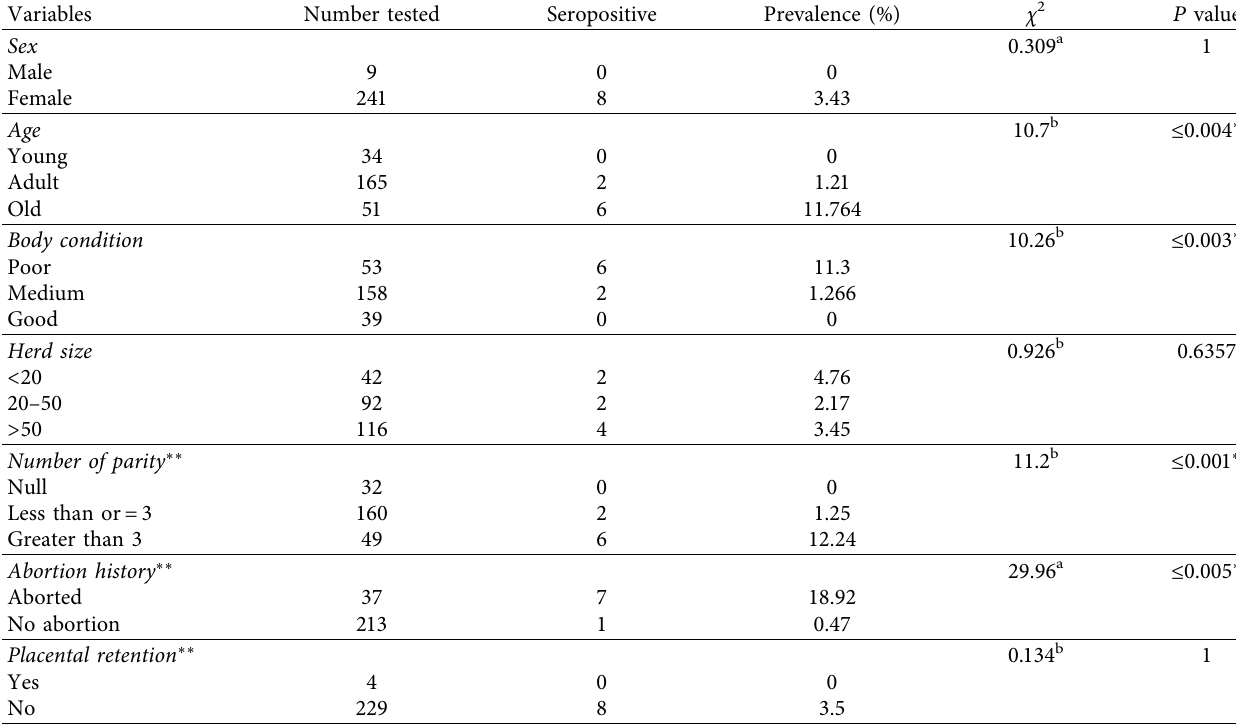
Table 2: Summary of Brucella seropositivity in camels and association of potential risk factors. Variables